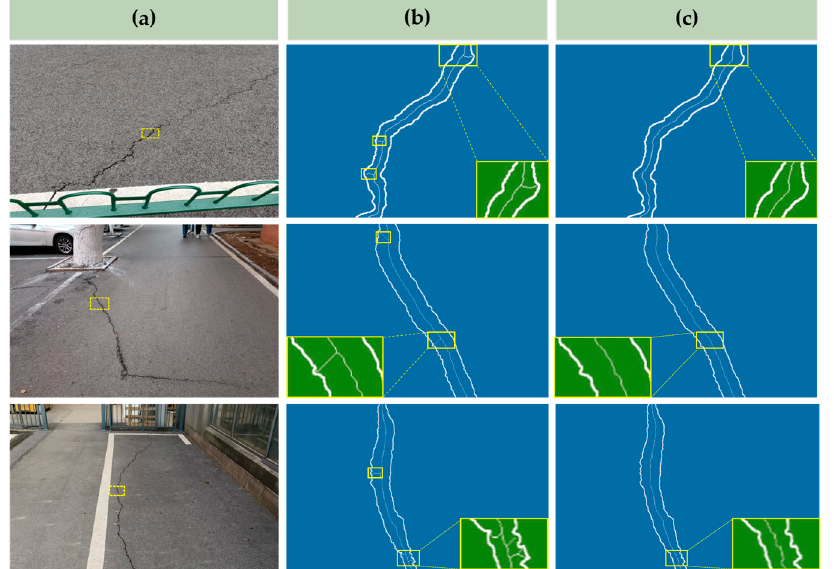
Figure 15. Comparison between the traditional thinning method and the proposed algorithm in this